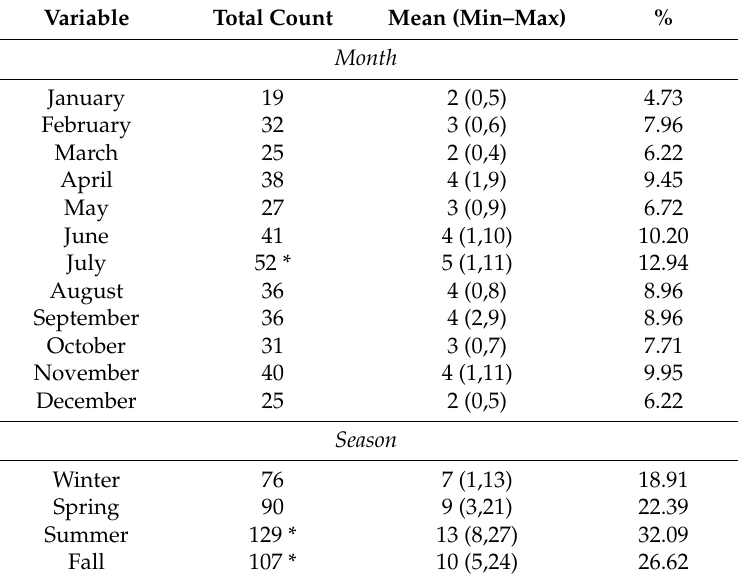
Table 2. Monthly and seasonal counts of DWAs issued in First Nations community drinking water systems in Ontario, 2004–2013.